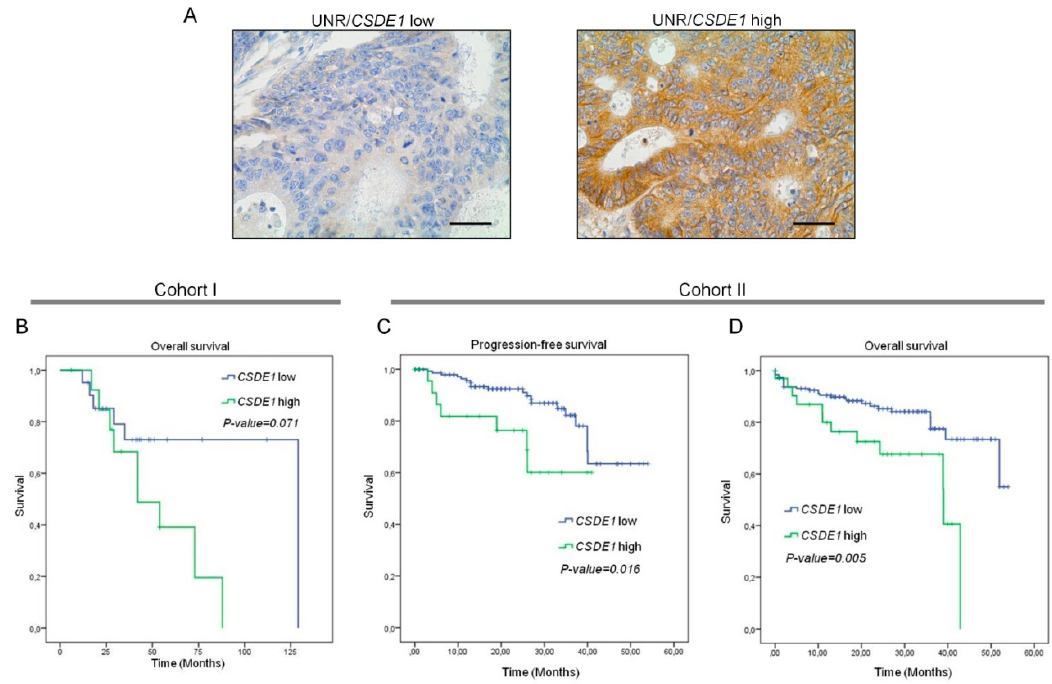
Figure 5. UNR / CSDE1 expression predicts poor prognosis in CRC patients. ( A ) Representative micrographs of a low- ( left ) and high- ( right ) UNR expression tumors. Scale bars: 100 µ m. ( B ) Kaplan-Meier curve for overall survival analysis of CRC patients that conforms cohort I. ( C , D ) Kaplan-Meier curves of cohort II for progression-free and overall survival analysis, respectively. p -value has been obtained by log-rank test.